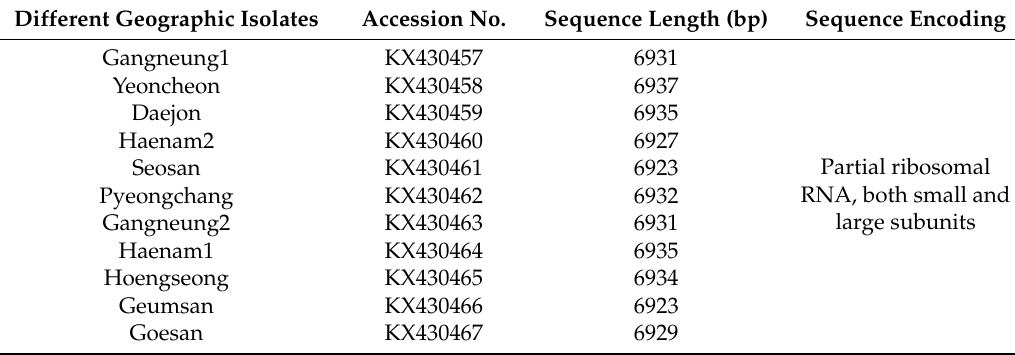
Table 2. GenBank accession numbers of the sequenced